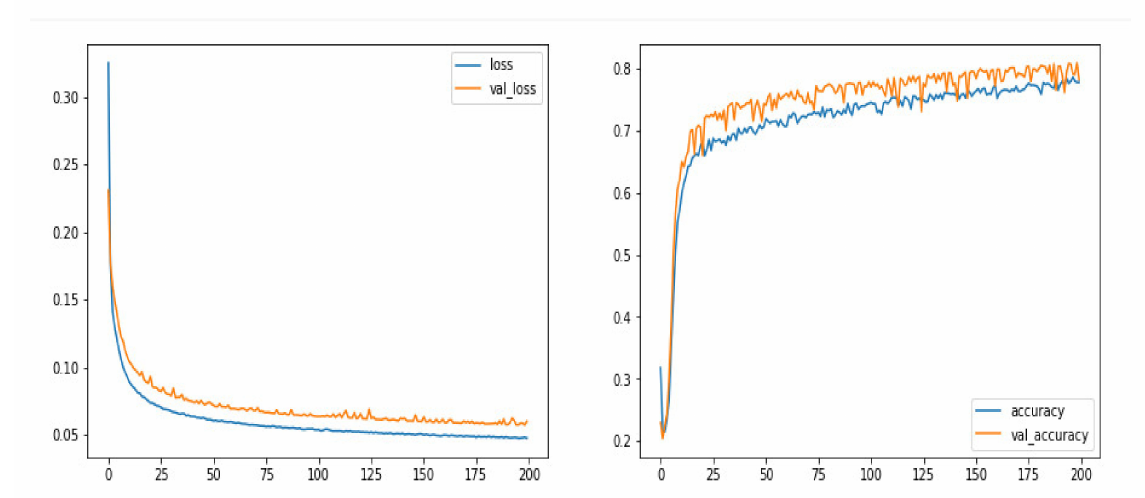
Figure 15. Plot of various parameters obtained from training and validation.